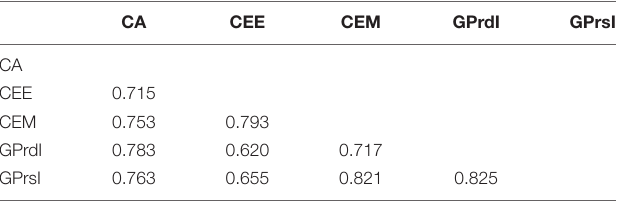
TABLE 3 | Heterotrait-monotrait (HTMT)